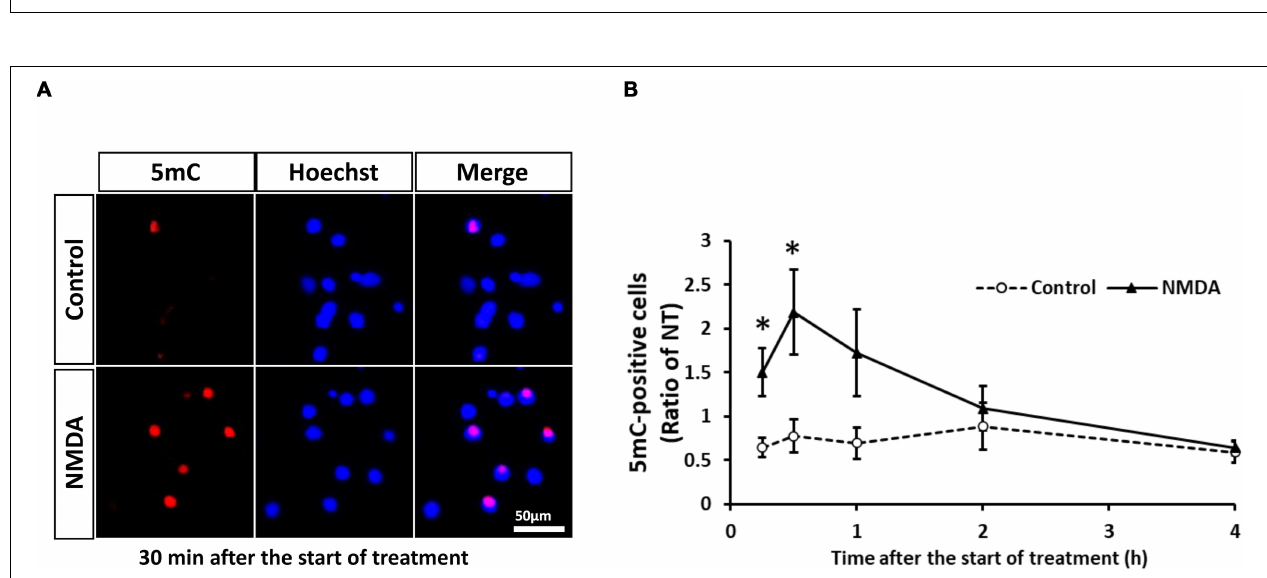
FIGURE 4 | (A) Representative images of 5mC immunostaining 30 min after start of treatment. The scale bar shows 50 µ m. (B) Changes in the ratio of 5mC-positive neurons to total cells (Hoechst-positive cells) after start of NMDA (closed triangle) or vehicle (open circle) treatment. Images of random four areas (each area of 1.3 mm 2 ) of each well were taken, and 302–1,250 cells were counted in each well. Results are the means ± SD ( n = 7 independent experiments). *Significant difference against the control group of the same time point ( p < 0.05). NT, non-treated